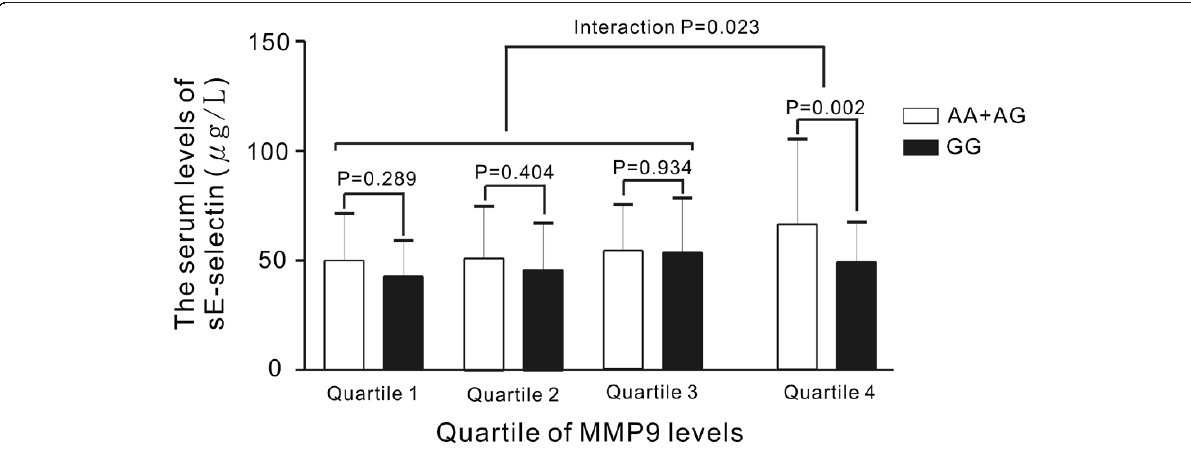
Figure 1 Interactive effect of MMP9 levels on the association between rs10800469 and sE-selectin levels. After adjusting for clinical covariates, minor allele of rs10800469 of the SELE gene was found to be associated with decreased sE-selectin levels, predominantly in highest quartile of MMP9 levels subjects ( P = 0.002). Interaction analysis revealed an interaction of MMP9 levels with the rs10800469 genotype (interaction P = 0.023, after the adjustment of age, gender, BMI, smoking, sICAM1 and MMP9).